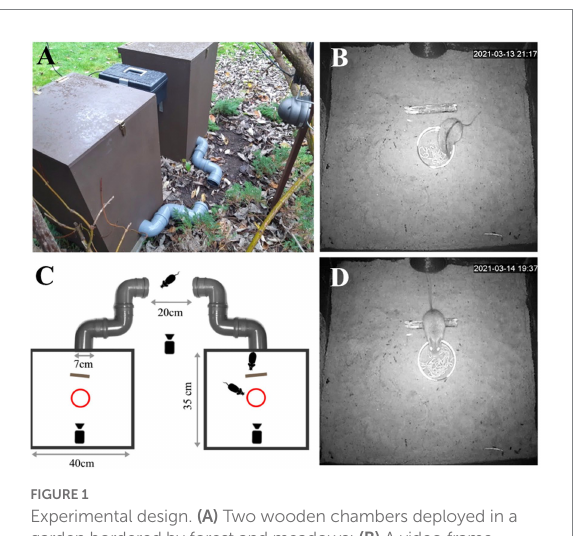
FIGURE 1 Experimental design. (A) Two wooden chambers deployed in a garden bordered by forest and meadows; (B) A video frame showing a striped field mouse ( Apodemus agrarius ) feeding inside a chamber; (C) Top view of the experimental setup schematic; (D) A video still showing a yellow-necked mouse ( Apodemus flavicollis ) inside the